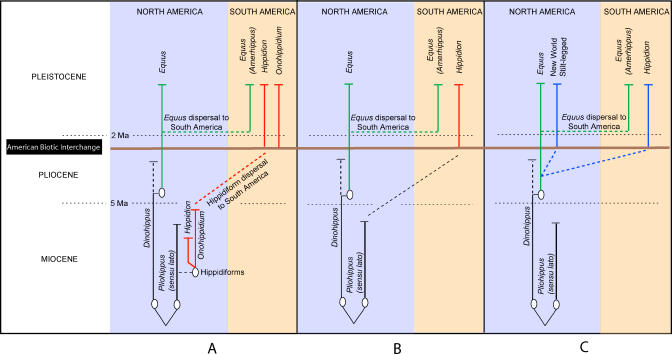
Diagrammatic Representation of North and South American Equid Taxonomy Superimposed on a Time Scale according to Paleontological (A, B) and Molecular Data (C)(A) represents MacFadden's [13] view of hippidiform origins from a pliohippine, diversifying into two genera, Hippidion and Onohippidium, in North America during the Miocene. (B) shows Alberdi and Prado's [14,15] view of hippidiforms as descendants of a pliohippine during the Miocene; the single genus, Hippidion, originates only after dispersal into South America (they do not recognize the genus Onohippidium as valid [15]). (C) represents the results of the molecular data presented in the present study; it shows Hippidion as originating during the Pliocene, c. 3-3.5 Ma ago. The NWSL is possibly a sister species of Hippidion.